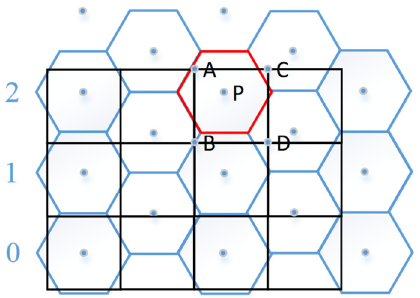
Figure 4. Schematic diagram of interpolation operation.